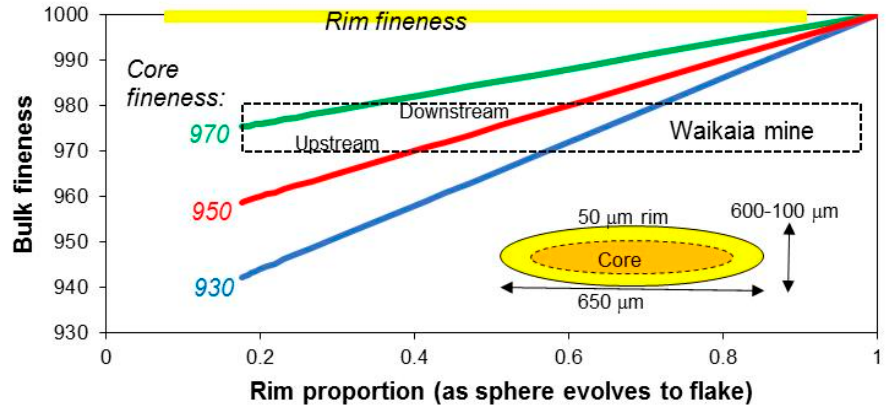
Figure 9. Modelled bulk fineness of placer gold mine products (doré bars) that result from particles with varying proportions of Ag-poor rims, with a range of average core Au fineness relevant to the Waikaia placer mine (dashed box).